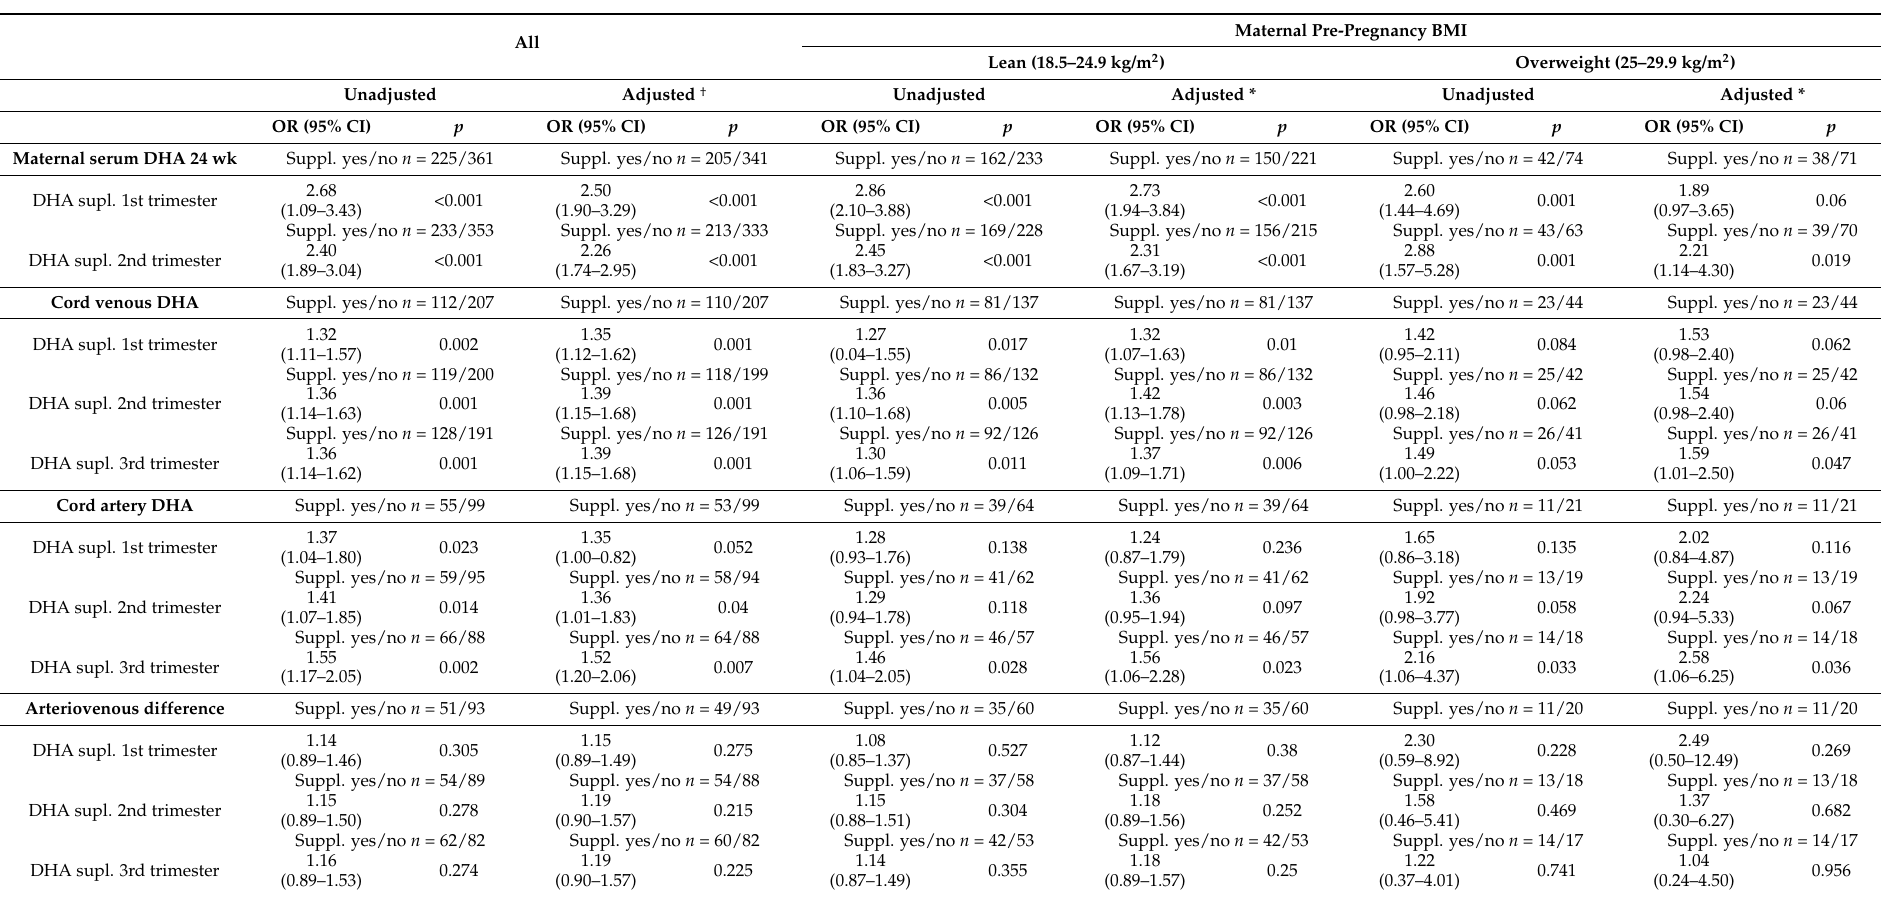
Table 4. Logistic regression analysis assessing the odds of having different response to dietary DHA supplements depending on maternal pre-pregnancy body mass index (BMI). The NELA study